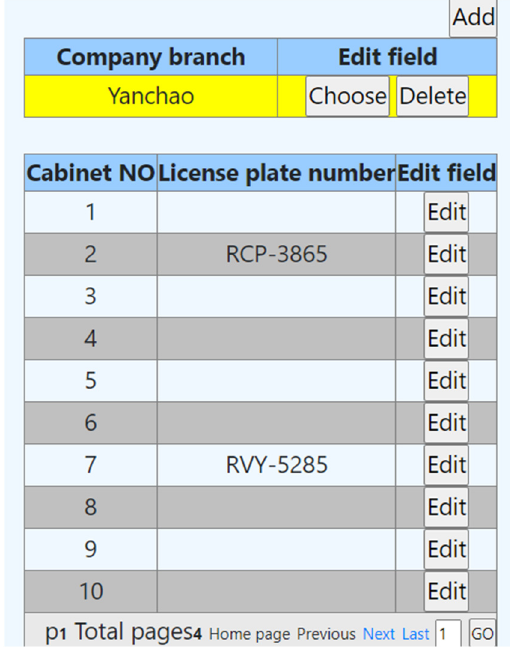
Figure 38. Field management menu.